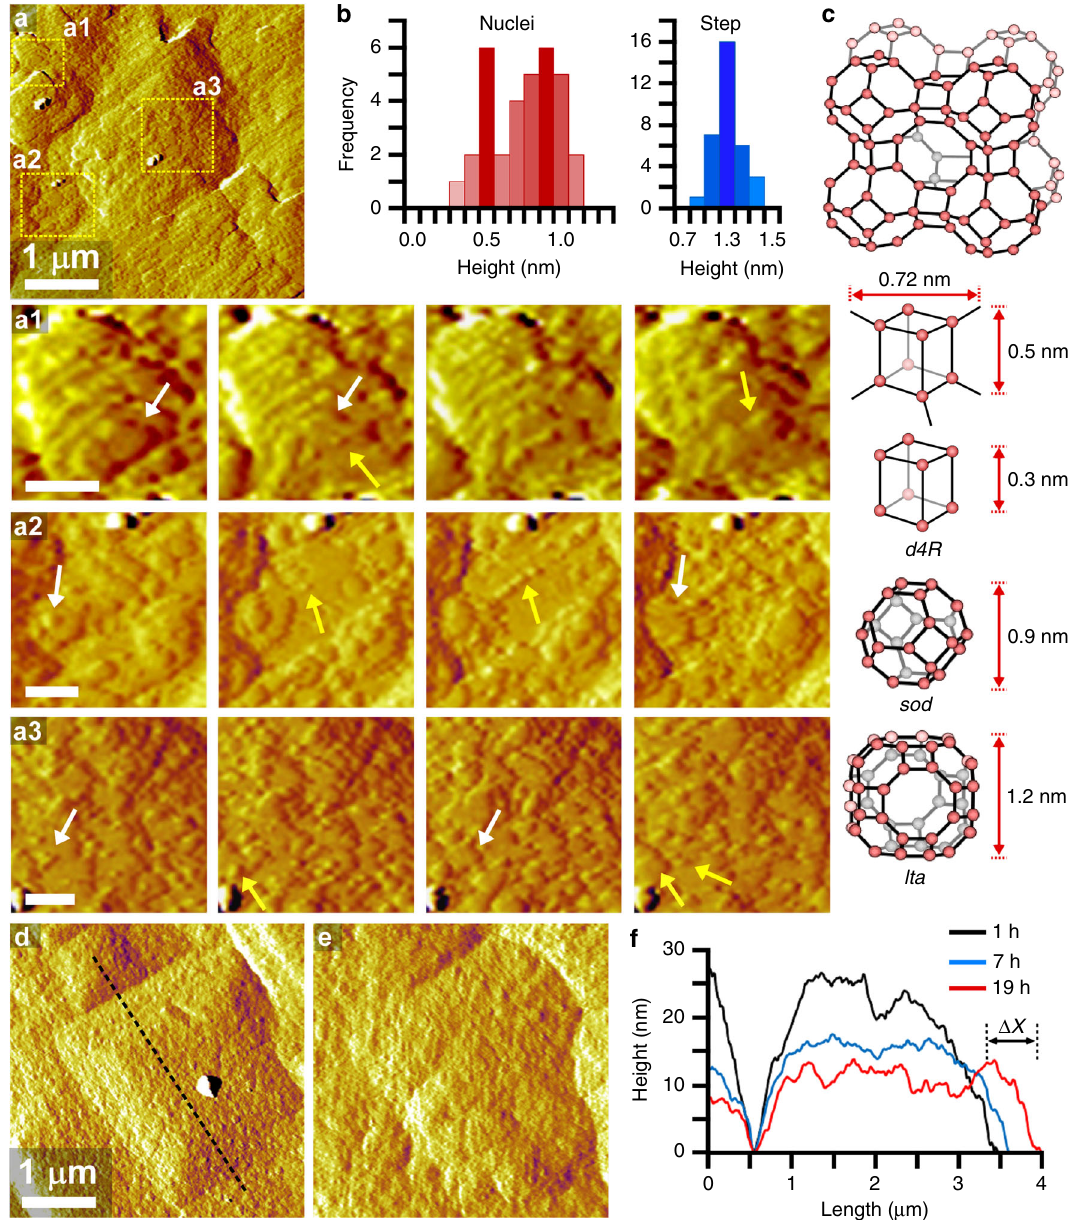
Fig. 4 Two-dimensional layer-by-layer growth. a AFM amplitude mode image of a crystal surface in solution S4 (low supersaturation) at 45 °C. Snapshots from Supplementary Movie 4 in selected areas a1, a2, and a3 highlight the dynamics of surface growth (total imaging time = 30 min). White and yellow arrows depict layer growth and nuclei formation, respectively. b Statistical analysis of nuclei (red) and step (blue) heights measured in multiple frames of Supplementary Movie 4 (total imaging time = 90 min). c LTA framework and composite building units: double-four-membered ring ( d4R ), sodalite ( sod ) cage, and lta cage. d , e Time-resolved AFM amplitude mode images of a crystal surface growing in solution S3 at 45 °C: d 1 h after reaching the set point and e after 19 h of growth. f Temporal changes in the height pro fi le along the dashed line in d . Scale bars are equal to 200 nm unless otherwise